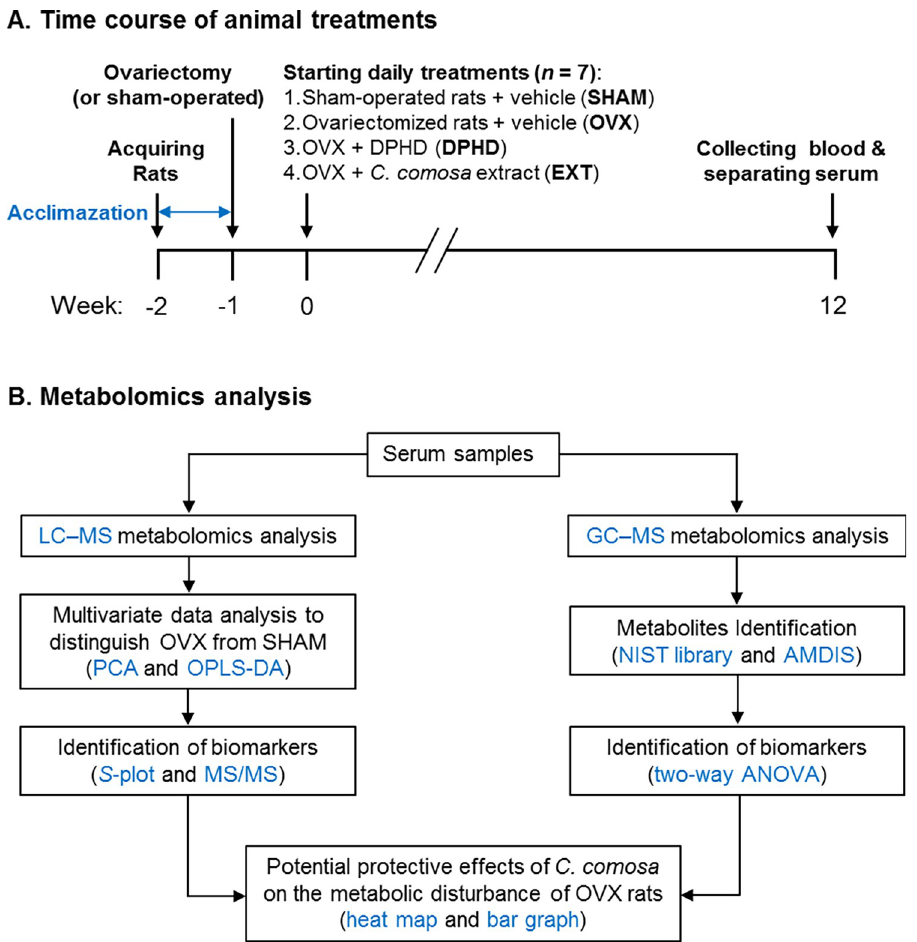
Fig 1. Schematic diagram of (A) experimental procedures and (B) metabolomics